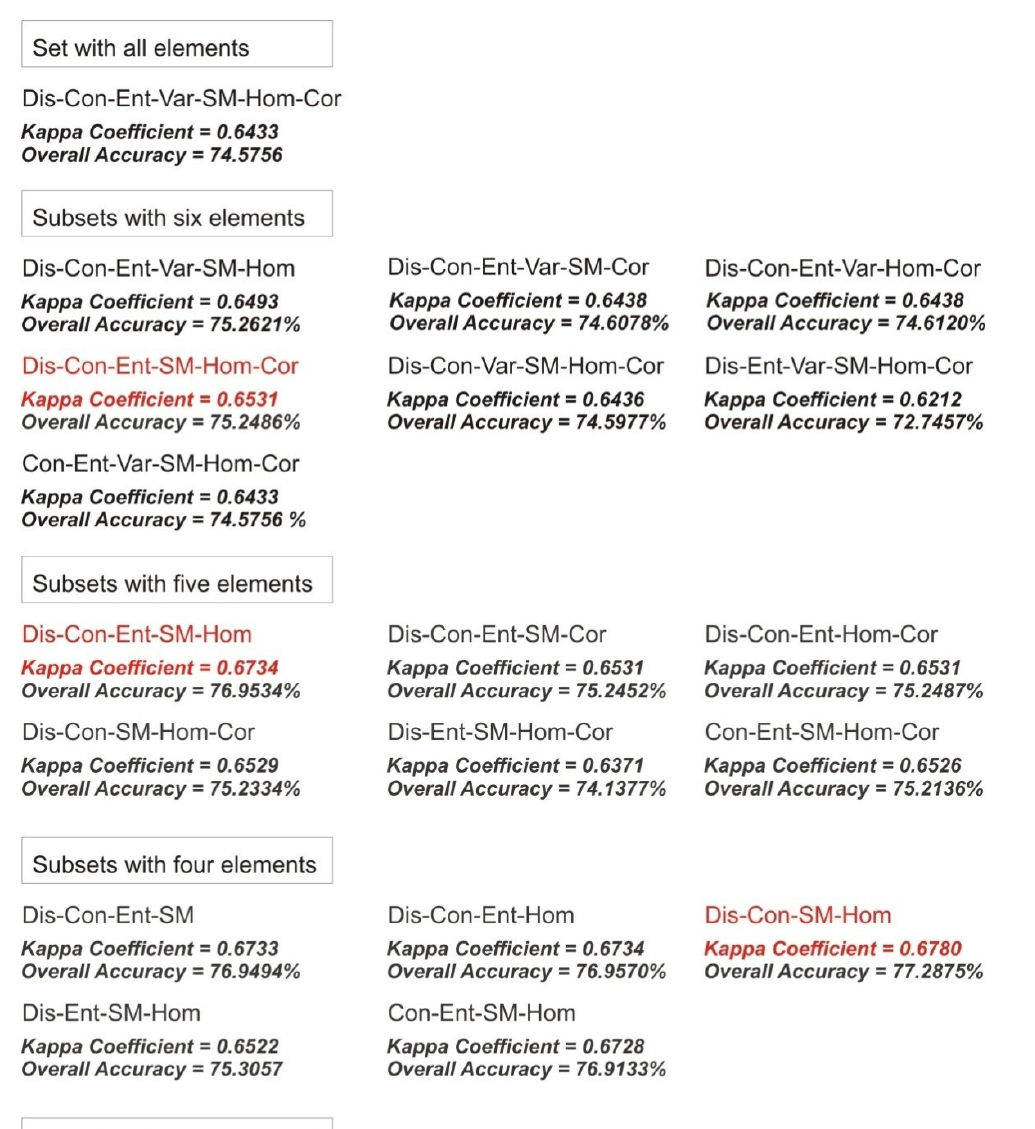
Figure 15. Sequential search scheme for the selection of the best GLCM